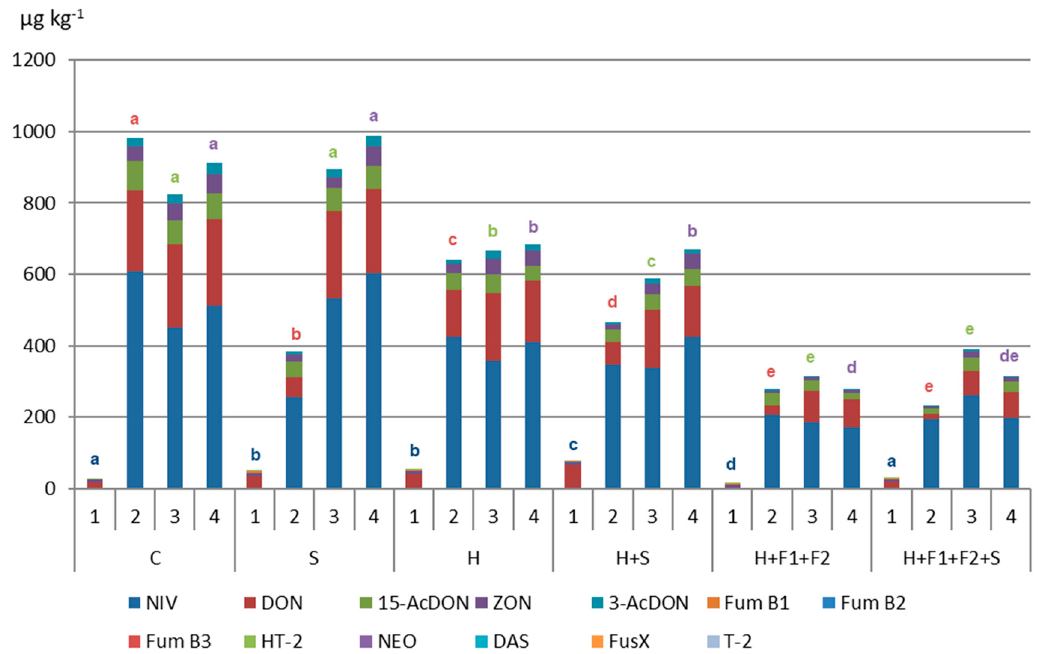
Figure 3. Mycotoxins concentration in wheat grain in four years of the study (1—2017; 2—2018; 3—2019; 4—2020). C—Control; S—biostimulator; H—herbicide; F1—fungicide 1; F2—fungicide 2. Bars marked with the same letter do not differ significantly ( p ≥ 0.05) in the particular year of the study. Table 3. Mycotoxins concentration in diverse strategies of crop protection in four years of the study (1—2017; 2—2018; 3—2019; 4—2020). The same letter in the particular year of the study indicates that the value is not significantly different ( p ≥ 0.05).